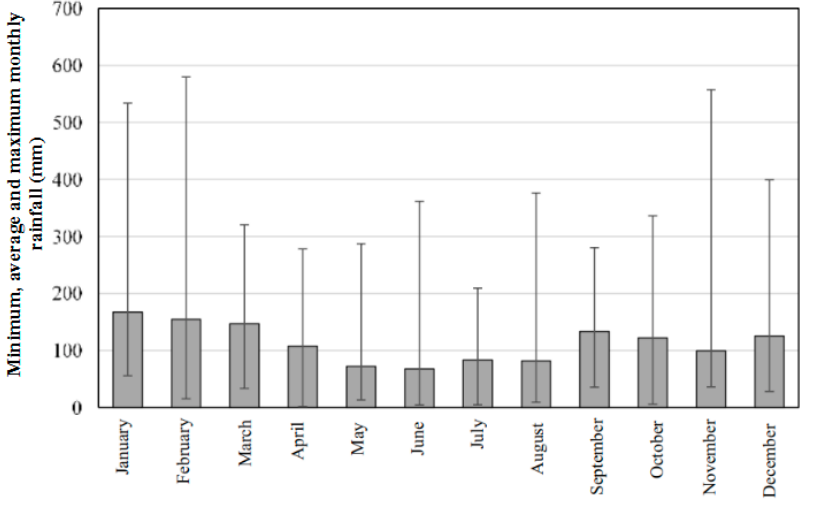
Figure 5. Minimum, maximum and average monthly rainfall in Florianópolis from 1996 to 2021 (based on [29]).